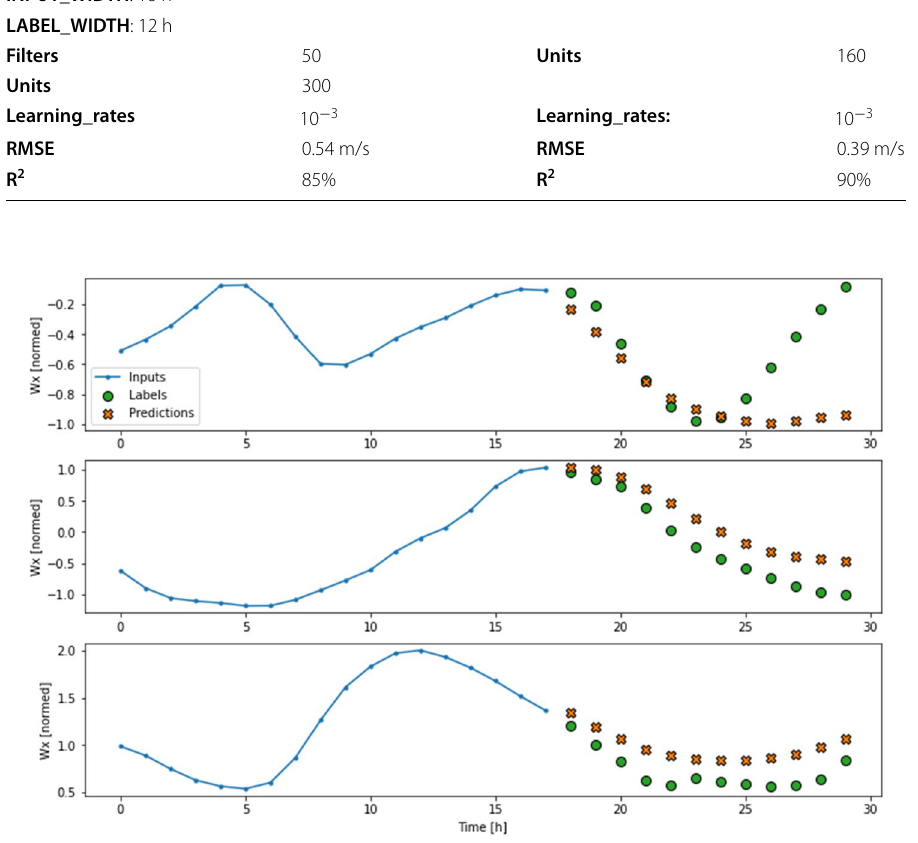
Fig. 22 W x forecast for 12 h on three portions of the test